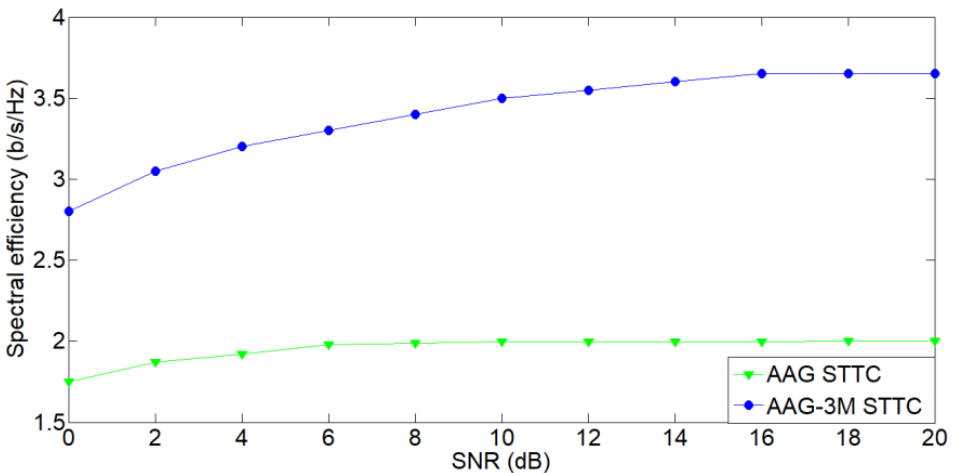
Figure 8. Comparison of spectral efficiency of AAG and AAG-3M STTC.